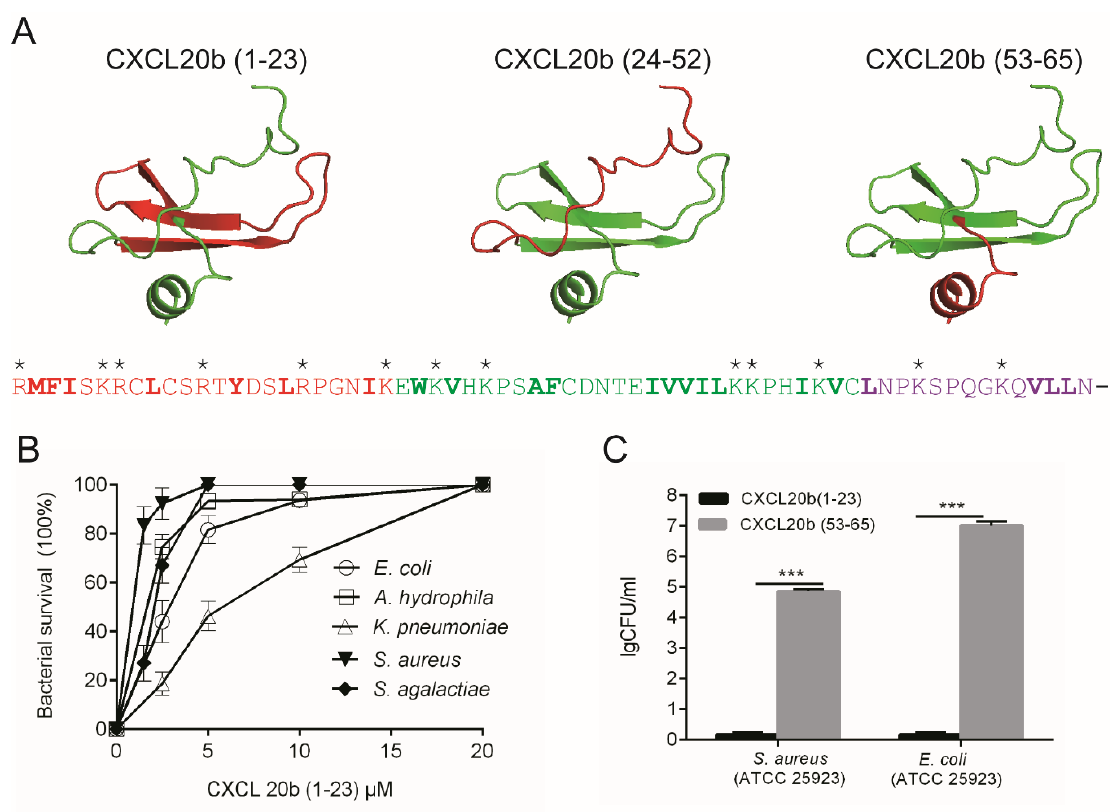
Figure 6. Sequence analysis and antimicrobial activity detection of grass carp CXCL20b fragments. ( A ) Secondary structure and sequence analyses. Target structure is in red, and other structures are in green. Sequences in red, green, and purple stand for the N-terminal random coil region (1–23), middle three antiparallel β -sheets region (24–52), and C-terminal α -helix region (53–65). Positive charge amino acids were marked by “*”. The hydrophobic amino acid residues were indicated in bold. ( B ) The antimicrobial activities of synthesized grass carp CXCL20b fragments were determined through CFU assays. N-terminal random coil peptide (1–23) with increasing concentrations was incubated for 30 min with Gram-positive bacteria S. aureus (ATCC 25923), S. agalactiae (ATCC 13813), and Gram-negative bacteria E. coli (ATCC 259220), K. pneumoniae (K13), and A. hydrophila (ATCC 7966). The middle β -sheets region (24–52) is insoluble. C-terminal α -helix region (53–65) did not show any antimicrobial activity against S. aureus (ATCC 25923) or E. coli (ATCC 25922) ( C ). Data from three independent experiments are shown as mean ± SD. *** p < 0.001.